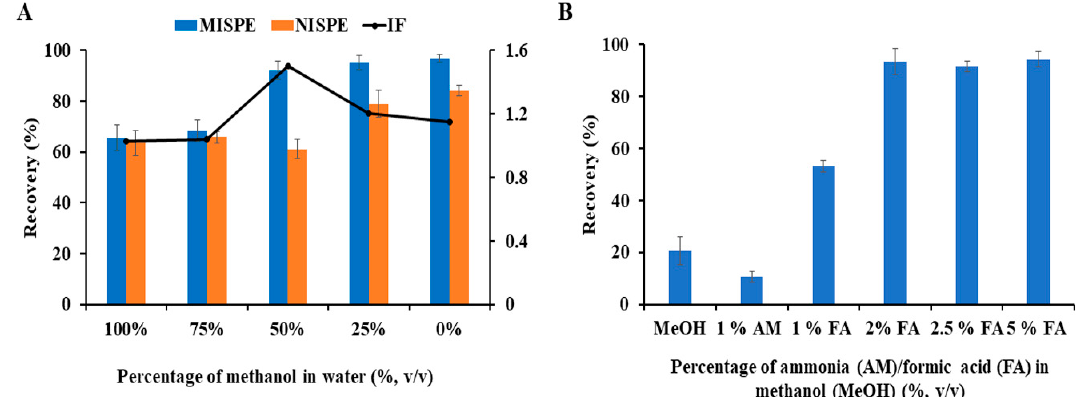
Figure 3. Effects of ( A ) different percentages of MeOH in water (%, v / v ) as washing solutions and ( B ) Figure 3. E ff ects of ( A ) di ff erent percentages of MeOH in water (%, v / v ) as washing solutions and methanol (MeOH), 1% ammonia (AM) in methanol and different concentrations of formic acid (FA) ( B ) methanol (MeOH), 1% ammonia (AM) in methanol and di ff erent concentrations of formic acid (FA) in methanol (%, v / v ) as eluting solutions on the recovery of colistin. in methanol (%, v / v ) as eluting solutions on the recovery of